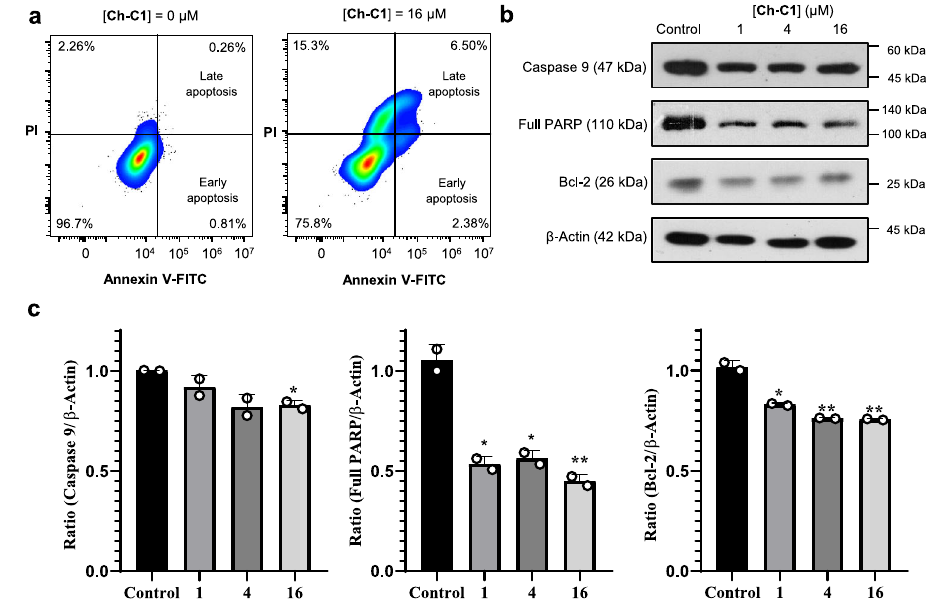
Fig.5|Nanoporesinducecancercellapoptosis.a EvaluationofHepG2apoptosis by fl ow cytometry, with Ch-C1 at 0 μ M and 16 μ M for 24h and cells stained using greenAnnexinV-FITCconjugateandredPIdye.AnnexinV=Intracellularproteinof the annexin family that recognizes phosphatidylserines; FITC=Fluorescein iso- thiocyanate. b Immunoblot assay for Caspase 9, PARP and Bcl-2 in HepG2 cells treated with up to 16 µ M of Ch-C1 for 24h. Results were analyzed via ImageJ 1.8.1 andreportedashistogramsbygraphpadprism8.01in c .Two-tailedStudent ’ s t -test